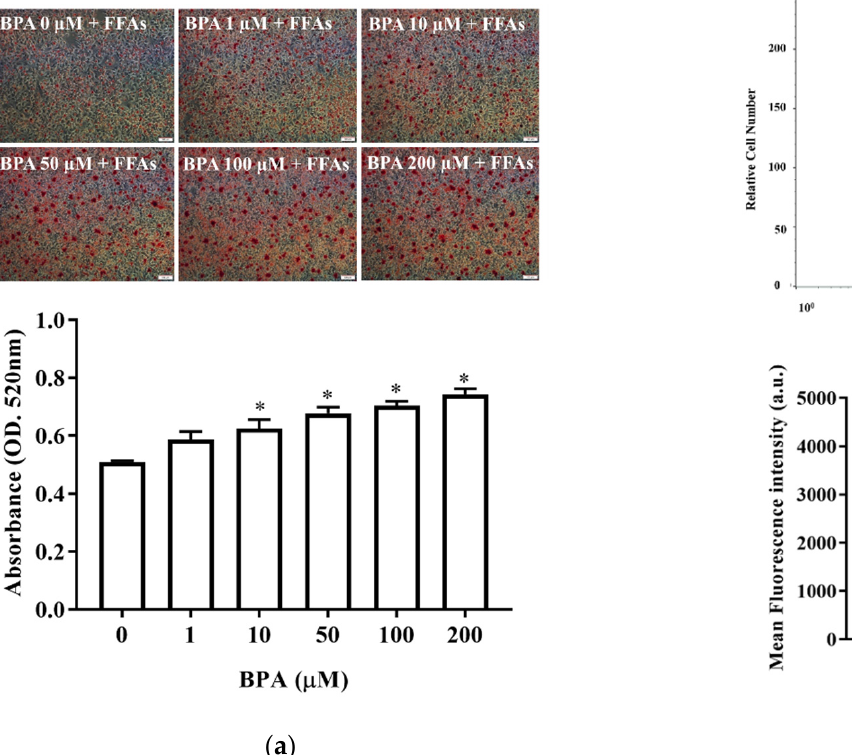
Figure 2. BPA increases hepatic lipid accumulation and fatty acid uptake: ( a ) Cells were treated with different doses of BPA plus FFAs (0.5 mM). Lipid droplets were stained using Oil Red O. The quantity of dye extracted from the stained cells was measured using spectrophotometry (be- low); ( b ) fatty acid uptake was determined using flow cytometry after exposure to BPA, in the absence or presence of LacCer, for 6 h. The histogram shows the mean of the fluorescence inten- sity results (below). The results are expressed as the mean ± SD of six independent experiments. * p < 0.05 vs. control (without BPA)